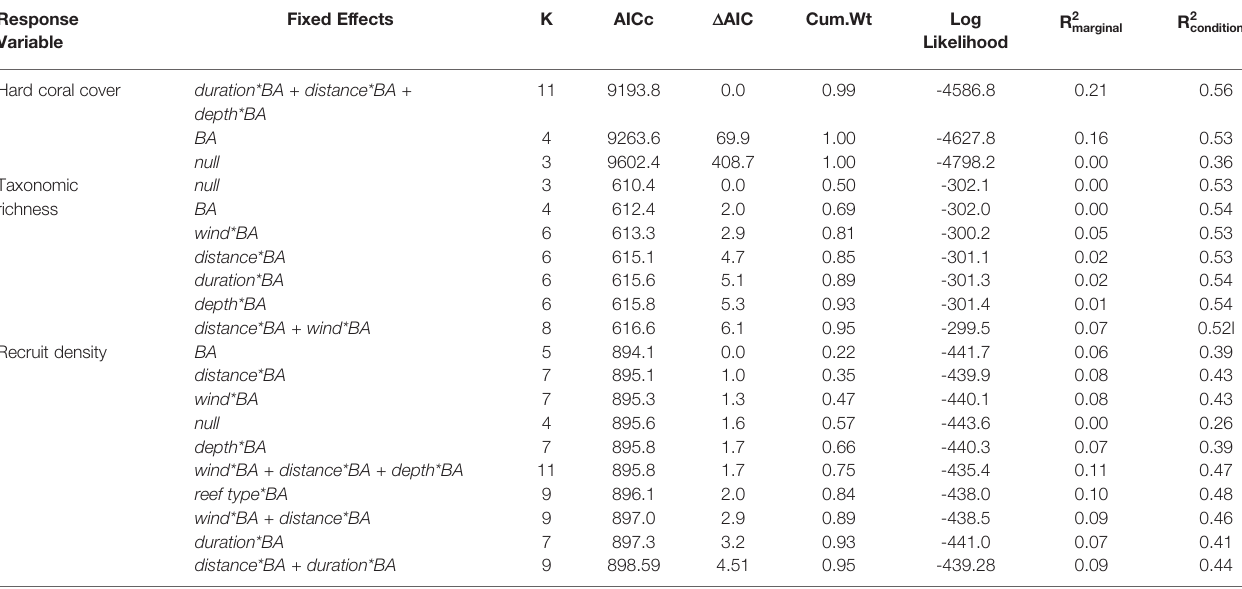
TABLE 1 | Hard coral cover (HCC), taxonomic richness and recruit density were modelled as a function of three cyclone parameters (i) wind (average maximum wind speed when the cyclone was within 70km of the reef site in m/s), (ii) duration (number of hours the cyclone was within 70km of the reef site) (iii) distance (minimum distance from centre of the cyclone to the reef site in km) and two reef characteristics (i) reef type and (ii) reef depth. Response